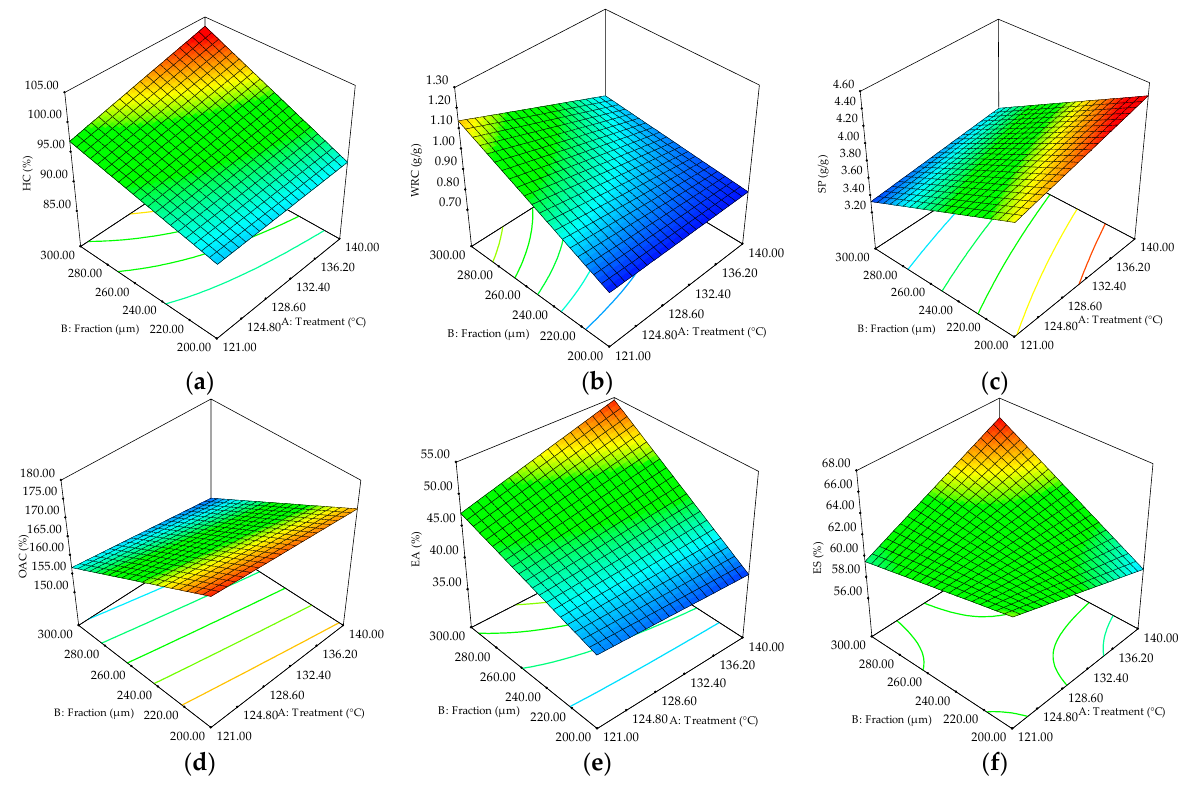
Figure 3. Three-dimensional graphic showing the combined effects of factors (treatment temperature and fractions) on the sorghum flour: ( a ) hydration capacity (HC), ( b ) water-retention capacity (WRC), ( c ) swelling power (SP), ( d ) oil-absorption capacity (OAC), ( e ) emulsion activity (EA), and ( f ) emulsion stability (ES).